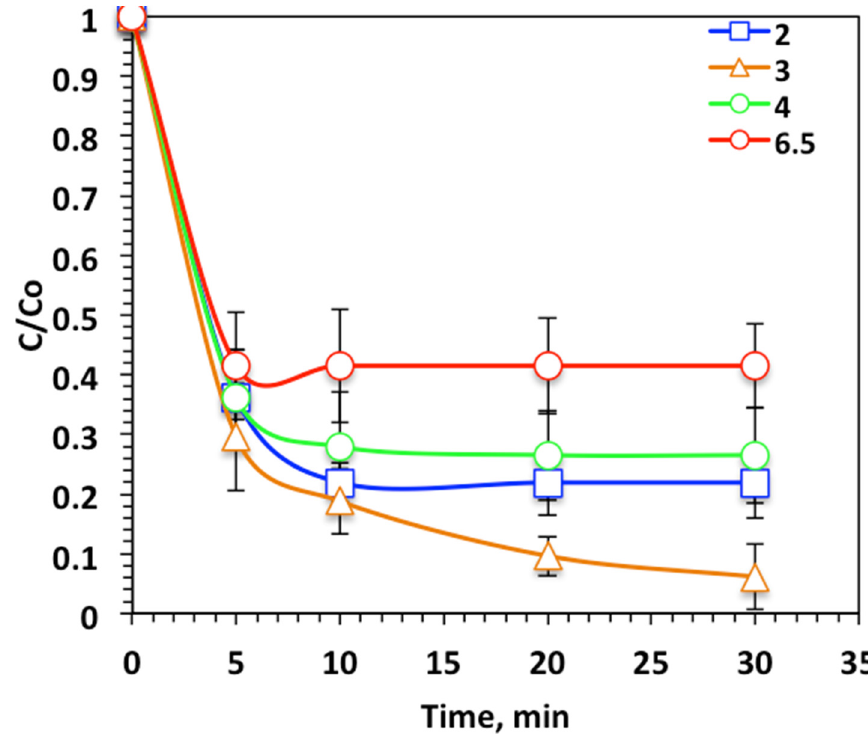
Figure 8. Effect of pH value on photo-Fenton-like oxidation-based WSD:Mag system.